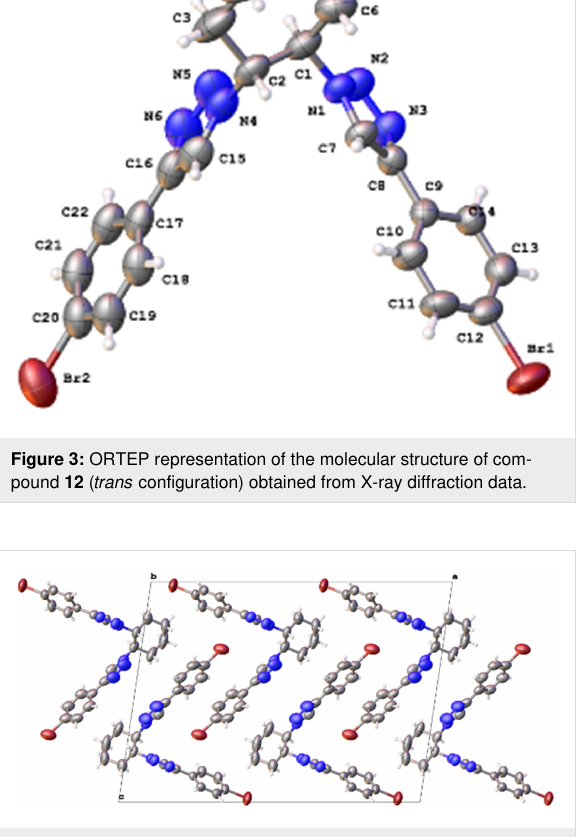
Figure 4: Crystal packing of compound 12 ( trans configuration) in